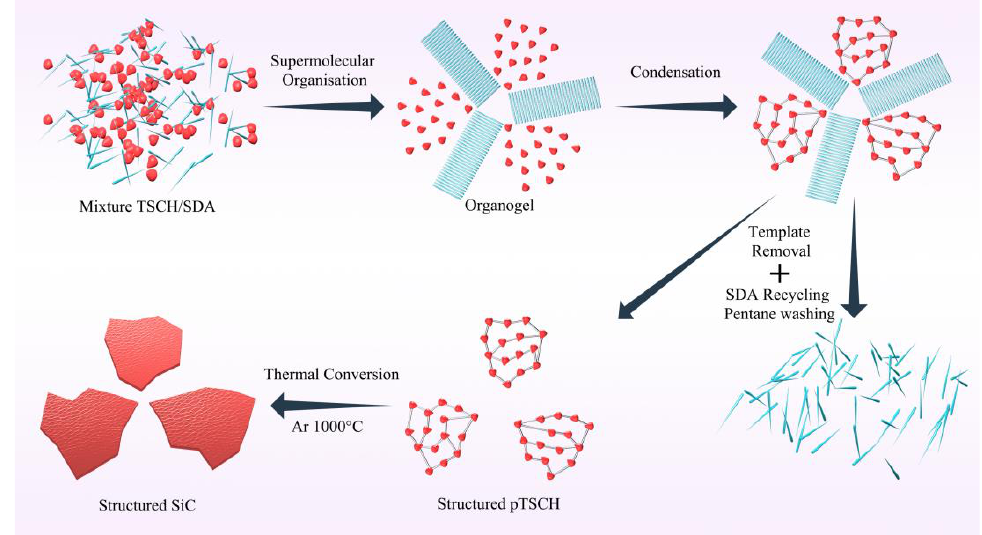
Figure 3. Schematic diagram of the preparation of SiC via soft templating.(the red pentagons represent the molecular precursor of SiC, and the blue graphic represents soluble directing agents). Adapted with permission from Ref. [70]. 2015, The Royal Society of